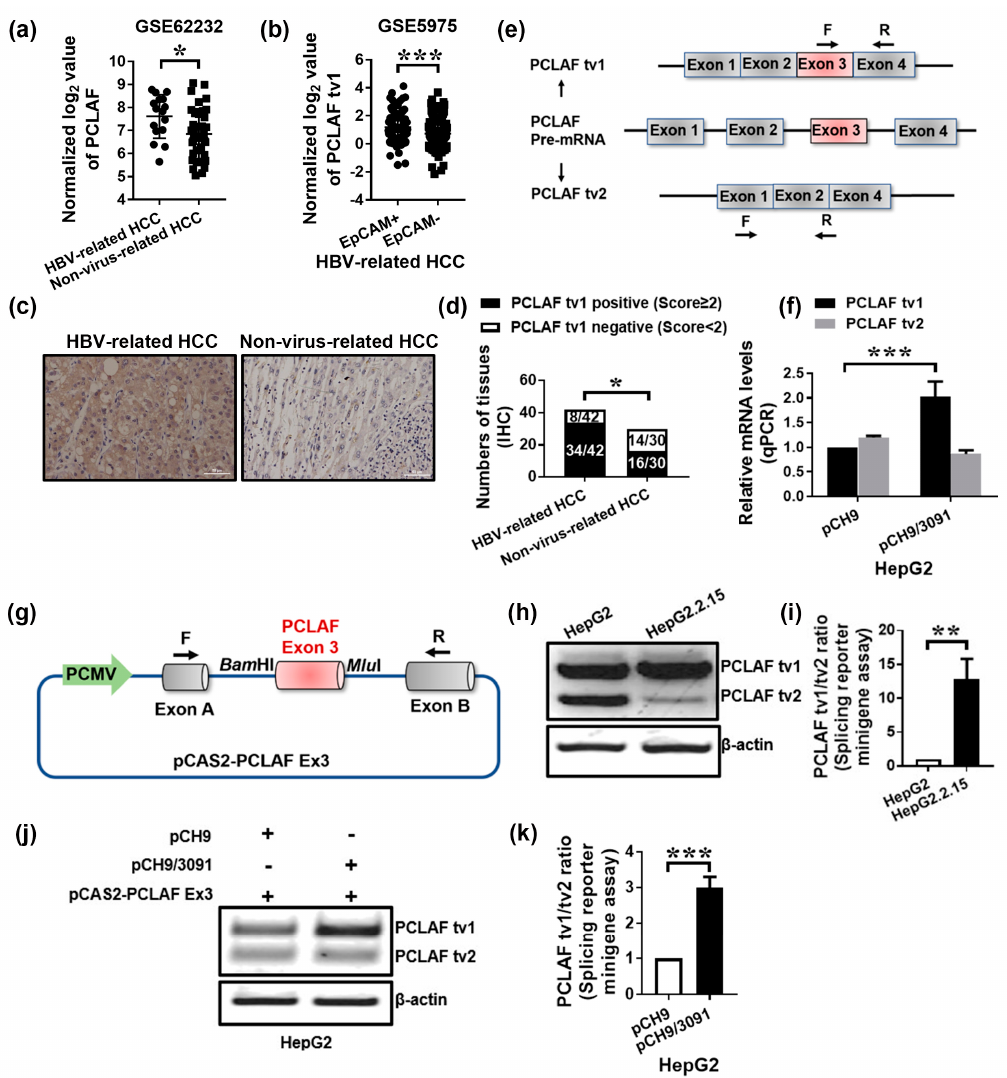
Figure 1. HBV increases PCLAF tv1 splicing in HCC cells. The normalized log 2 expression of PCLAF in GSE62232 was shown. * p < 0.05 ( a ). The normalized log 2 value of PCLAF tv1 in GSE5975 was presented. *** p < 0.001 ( b ). PCLAF tv1 staining in HBV-related HCC and non-virus-related HCC was detected using immunohistochemistry. The images are representative (scale bar, 50 μ m) ( c ). The graph displays the ratio of PCLAF tv1-positive to -negative in HBV-related HCC and non-virus-related HCC using immunohistochemistry. * p < 0.05 ( d ). Alternative splicing in human PCLAF pre-mRNA exon 3 resulted in the production of PCLAF tv1 and tv2 mRNAs. Furthermore, the primers specific for PCLAF tv1 and tv2 used in qPCR were identified ( e ). PCLAF tv1 and tv2 mRNA levels were measured in HepG2 cells transfected with pCH9 or pCH9/3091 by qPCR. *** p < 0.001 ( f ). The diagram depicts the assembly of the pCAS2-PCLAF Ex3 minigene. The PCLAF wildtype exon 3 and surrounding intronic sequences were inserted into the Bam HI and Mlu I restriction sites of the pCAS2 vector, which contained a two-exon splicing reporter minigene ( g ). Following transient transfection of the pCAS2-PCLAF Ex3 minigene in HepG2 and HepG2.2.15 cells, exogenous PCLAF tv1 and tv2 levels were measured using a splicing reporter minigene assay ( h ). The graph shows the tv1/tv2 ratio of exogenous PCLAF in HepG2 and HepG2.2.15 cells. ** p < 0.005 ( i ). Following transient transfection of the pCAS2-PCLAF Ex3 minigene in HepG2 cells transfected with pCH9 or pCH9/3091 plasmids, exogenous PCLAF tv1 and tv2 levels were assessed using a splicing reporter minigene assay ( j ). The graph shows the exogenous PCLAF tv1/tv2 ratio in pCH9 or pCH9/3091 plasmid transfected HepG2 cells. *** p < 0.001 ( k ).